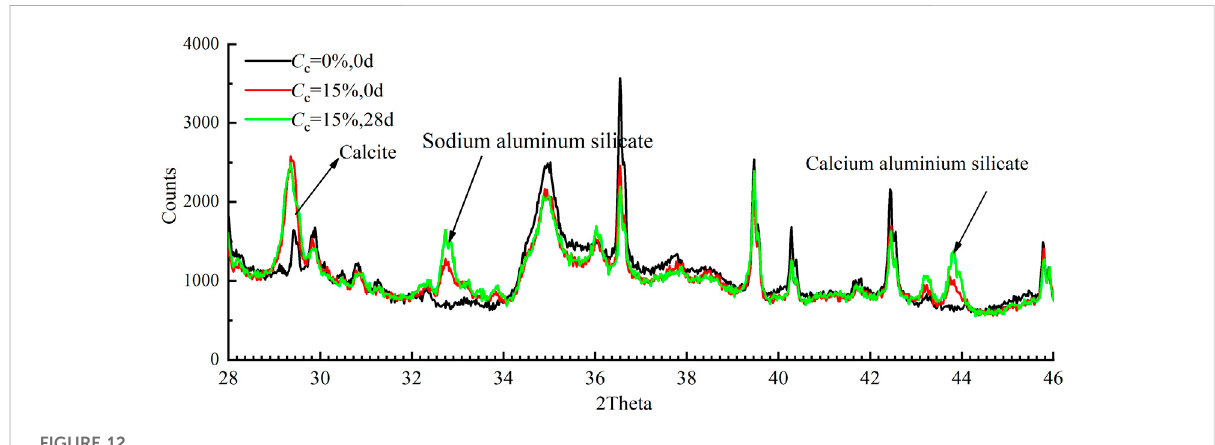
FIGURE 12 XRD spectrums of cement modi fi ed